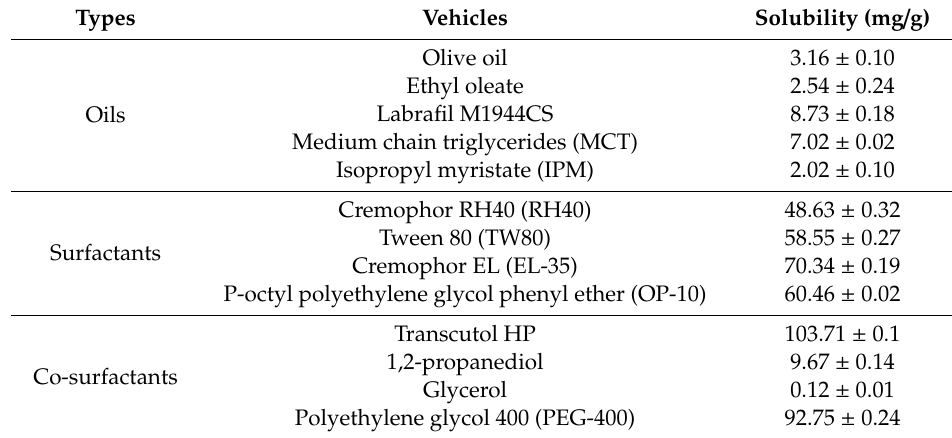
Table 2. Solubility of phillygenin (PG) in various oils, surfactants and co-surfactants (mean ±